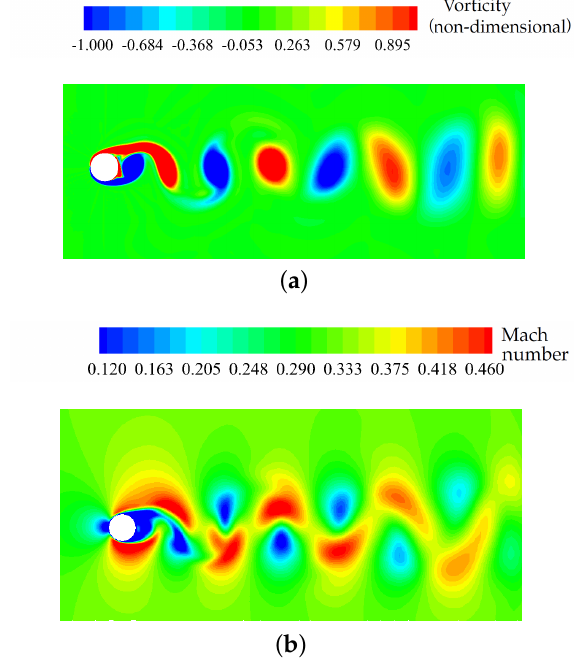
Figure 11. Snapshot of instantaneous flow field at t × a ∞ / d = 400 for laminar flow past a 2D cylinder. ( a ) Contours of vorticity magnitude; ( b ) Contours of velocity magnitude.